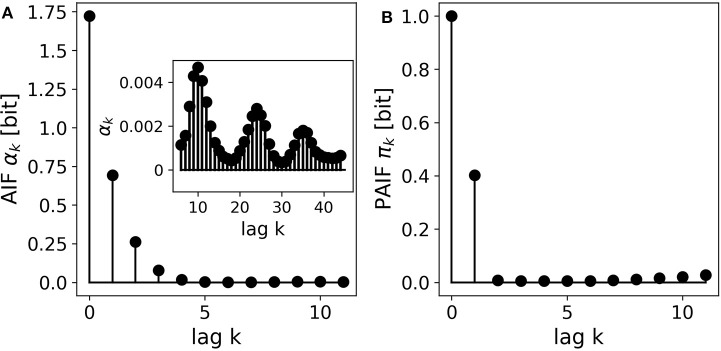
A 4-state resting state EEG microstate sequence. (A) The AIF shows a monotonous decay for smaller time lags k < 10. The inset shows the AIF for larger time lags (kmax = 50) and reveals periodicities that could not be predicted at shorter time scales. (B) The PAIF indicates a mainly first-order Markovian structure but does not allow the computation of time lags as large as the AIF due to the exponentially growing size of the associated distributions.